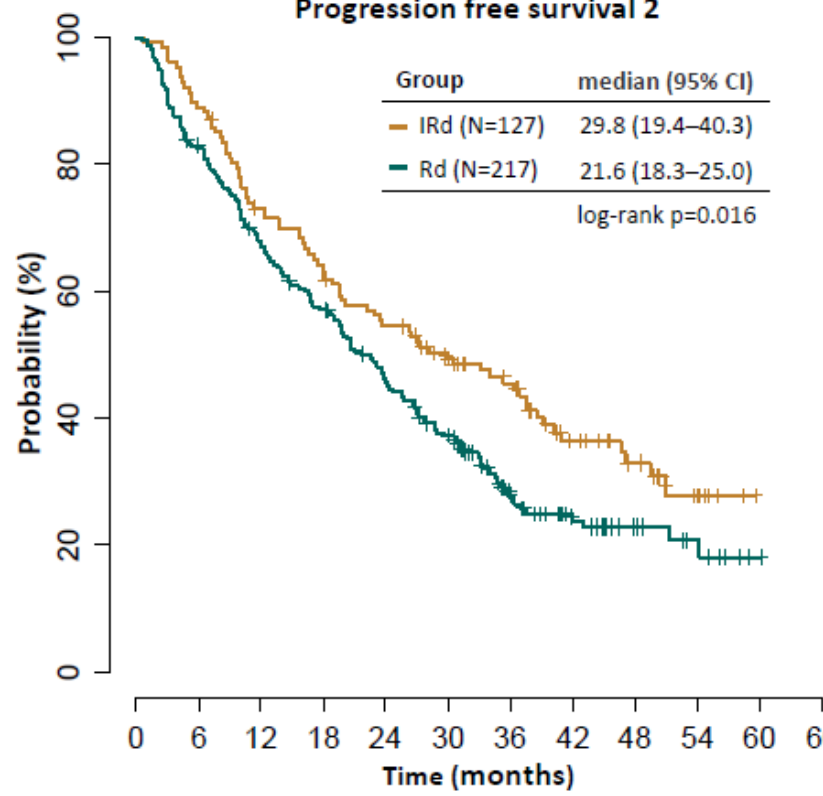
Figure 7. Progression free survival